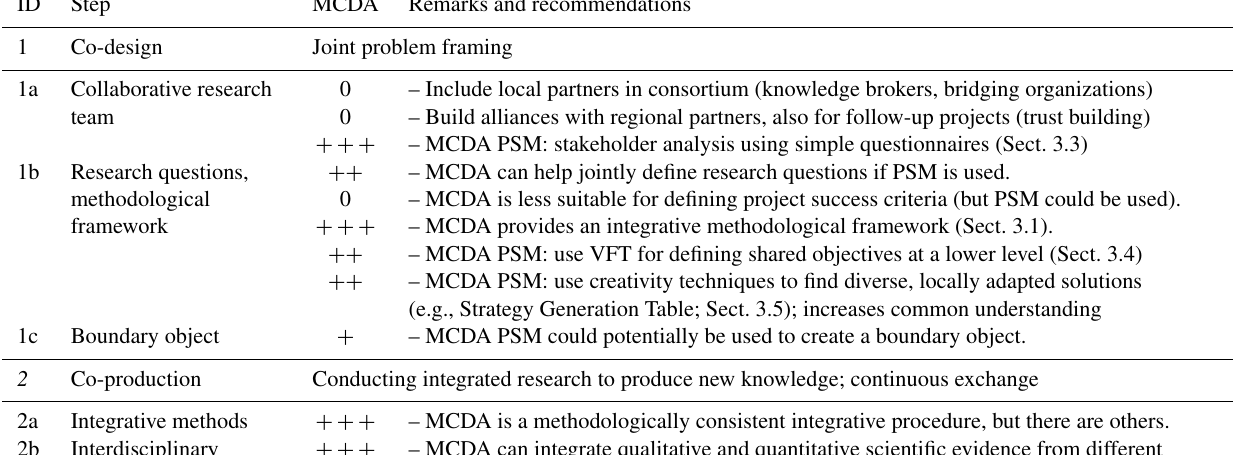
Table 4. Summary evaluation of the MCDA process using a conceptual framework for transdisciplinary research (Table 1): (1) co-design, (2) co-production, and (3) co-dissemination of knowledge. Symbols: +++ strength of MCDA; ++ well possible with MCDA; + possible contribution by MCDA; 0 not achievable by MCDA; ∗ remark. PSM: problem-structuring method; VFT: value-focused thinking.